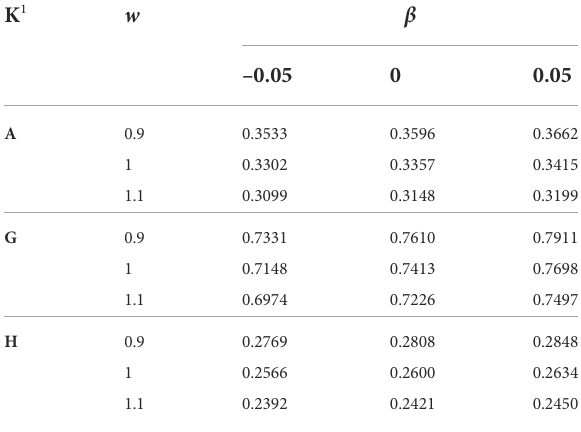
TABLE 3 The effect of w and β ( w K + α 11 ′ + β I) on the heritability estimate. K